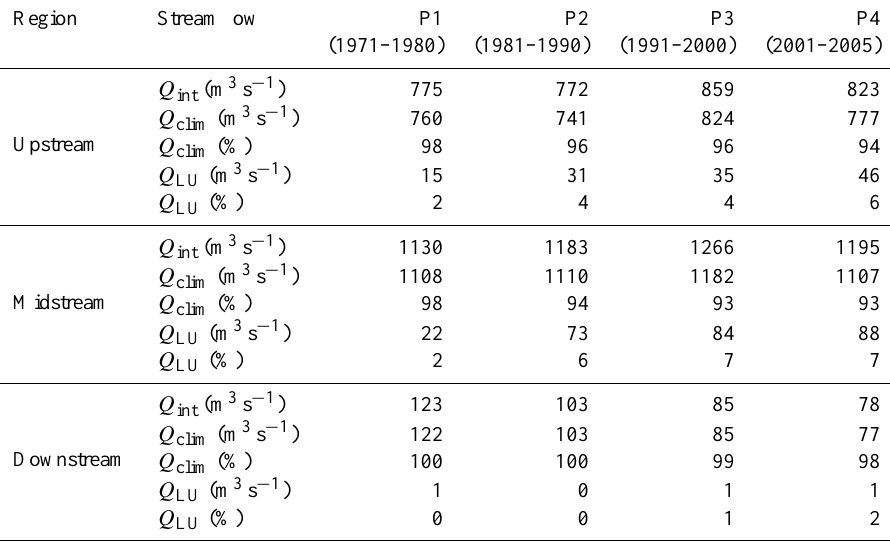
Table 6. Contribution of climate and LU to the streamflow for different time